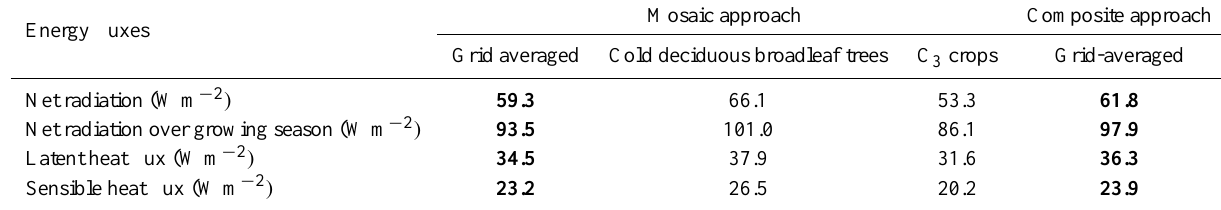
Table 2. Average annual values of primary energy fluxes at the Eastern United States location when using the composite and mosaic approaches.